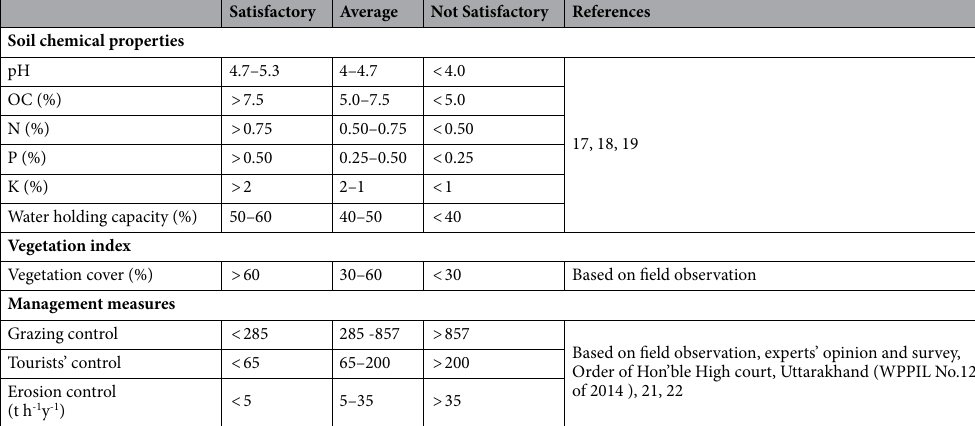
Table 5. Scoring criteria for calculation of restoration evaluation